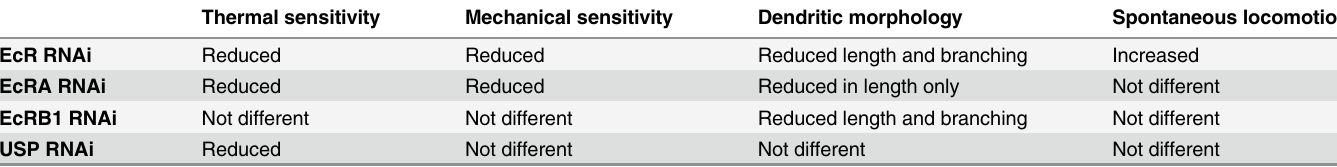
Table 1. Summary of consequences of nociceptor-specific RNAi suppression of EcR isoforms and USP. Thermal